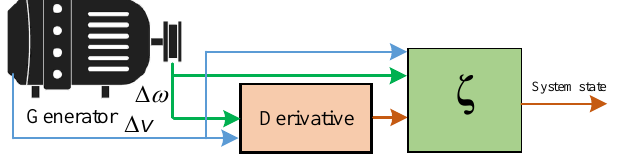
Figure 7. The process of determining the current state of the system.